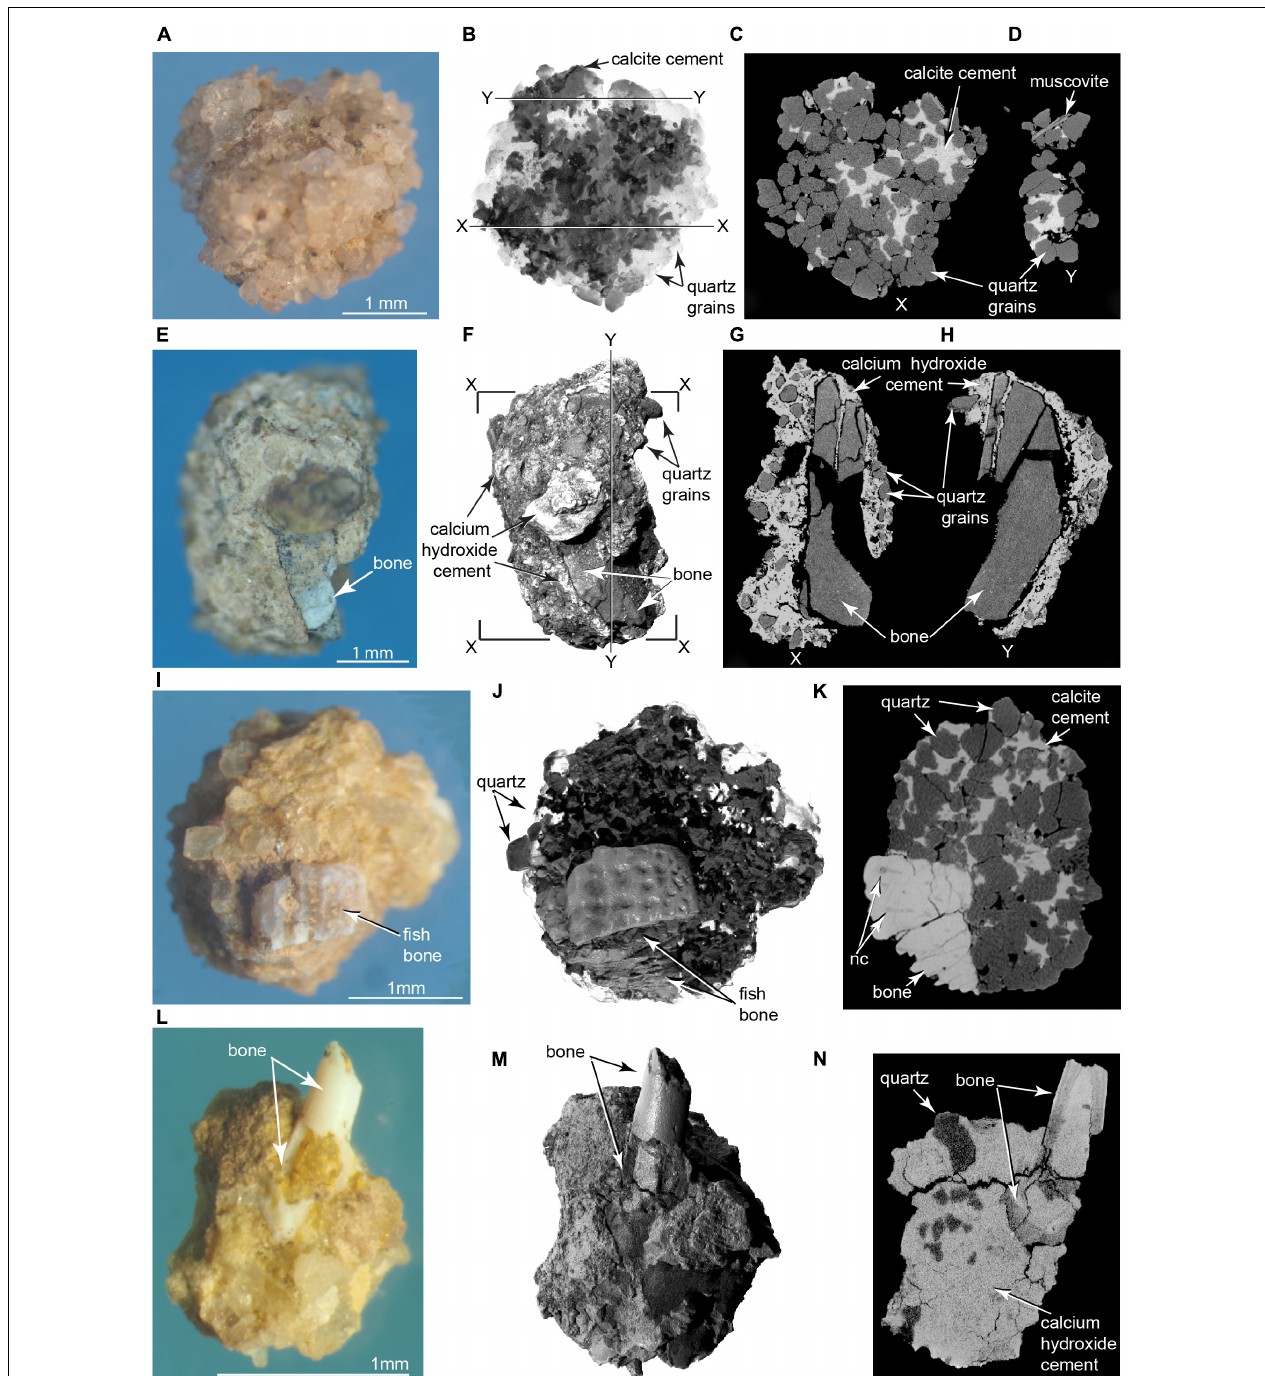
FIGURE 10 | Photomicrographs and µ CT imagery of pyrogenic microparticles. Siliceous aggregate in (A) photomicrograph, (B) volumetric 3D reconstruction from µ CT; (C,D) selected µ CT slices in planes X and Y. Calcite (darker material) identified using ESEM in (B) , and as lighter material in (C,D) (TMM 47004-3.11.8). (E–H) Complex aggregate enclosing calcined bone fragment. (E) Photomicrograph, (F) µ CT volumetric 3D reconstruction (G,H) µ CT slices across aggregate containing pulverized bone fragment. Note in (G,H) penetration of ash into fractured bone, indicating degassing, shrinkage, and fracture of the bone were penecontemporaneous with calcium hydroxide crystallization (TMM 47004-3.12.1). (I–K) Ornamented fish cranial element cemented into siliceous aggregate in (I) photomicrograph, (J) volumetric 3D reconstruction from µ CT, and (K) CT slice showing cementation of fish bone into the aggregate ( Supplementary Videos 9, 10 ). nc, nerve canal in fish bone (TMM 47004-3.5.31). (L–N) Hollow fish radiale incorporated into complex aggregate of quartz grains cemented by microcrystalline calcium hydroxide matrix (identified using ESEM). (L) Photomicrograph, (M) volumetric 3D reconstruction from µ CT; (N) µ CT slice showing laminated histology of imbedded bone (TMM